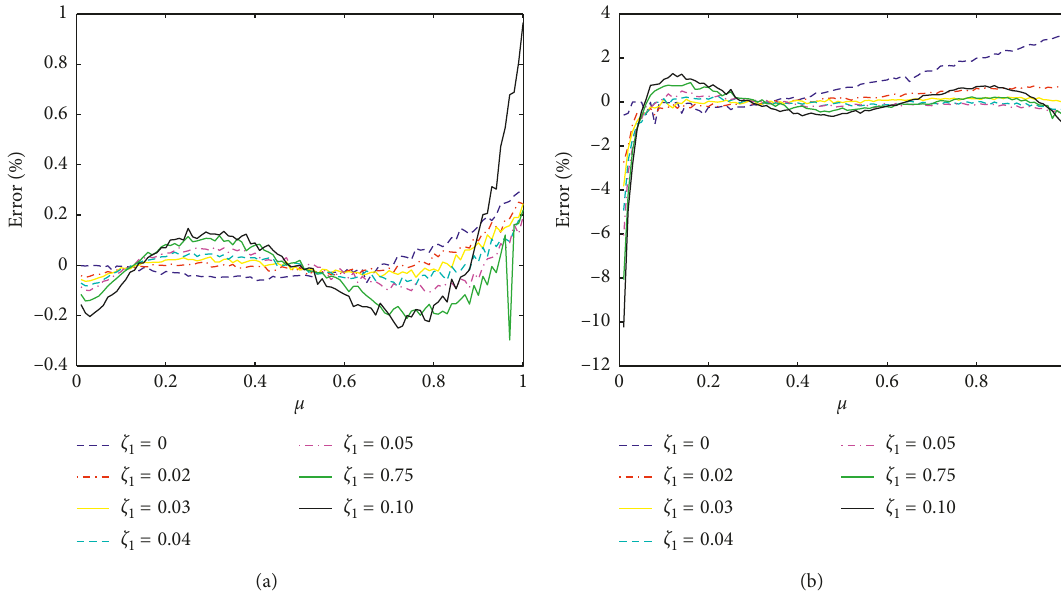
Figure 5: The error rate of the revised fitting formula value with the TMD mass ratio and the damping ratio of the main structure under the excitation of harmonic load. (a) Error rate of the frequency ratio. (b) Error rate of the damping